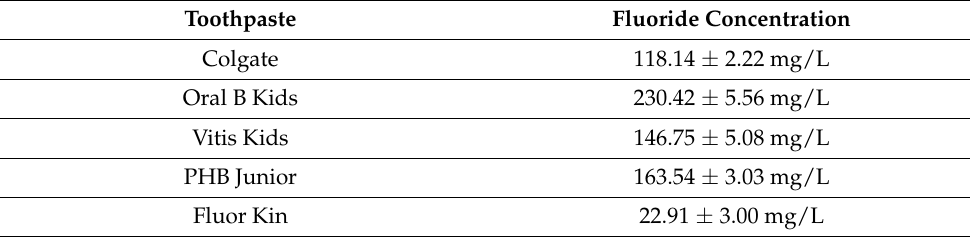
Table 3. Ion fluoride